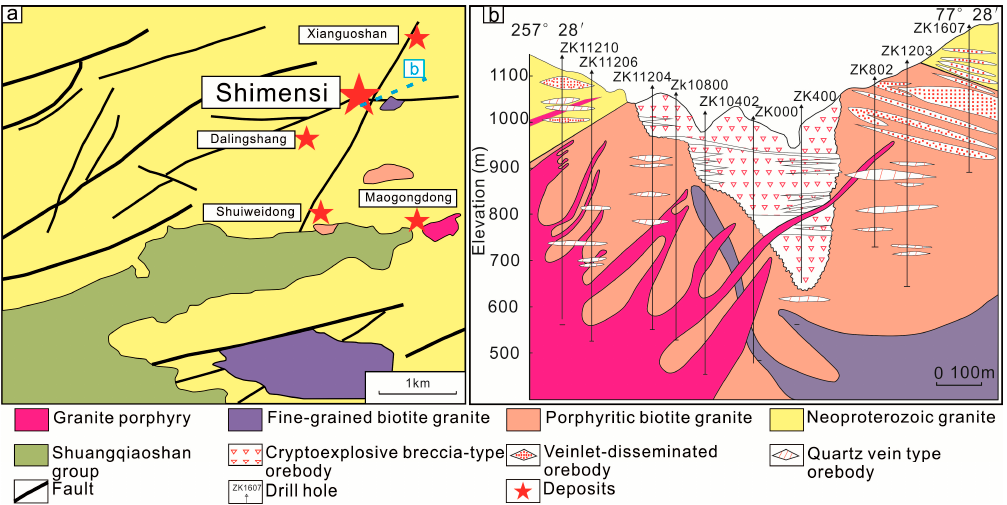
Figure 2. ( a ) Sketch geological map of the Jiuling Mountains. ( b ) A NE-trending cross-section of the Shimensi deposit showing three tungsten ore types: veinlets-disseminated, breccia-type, and vein-type mineralization (modified after [19]).